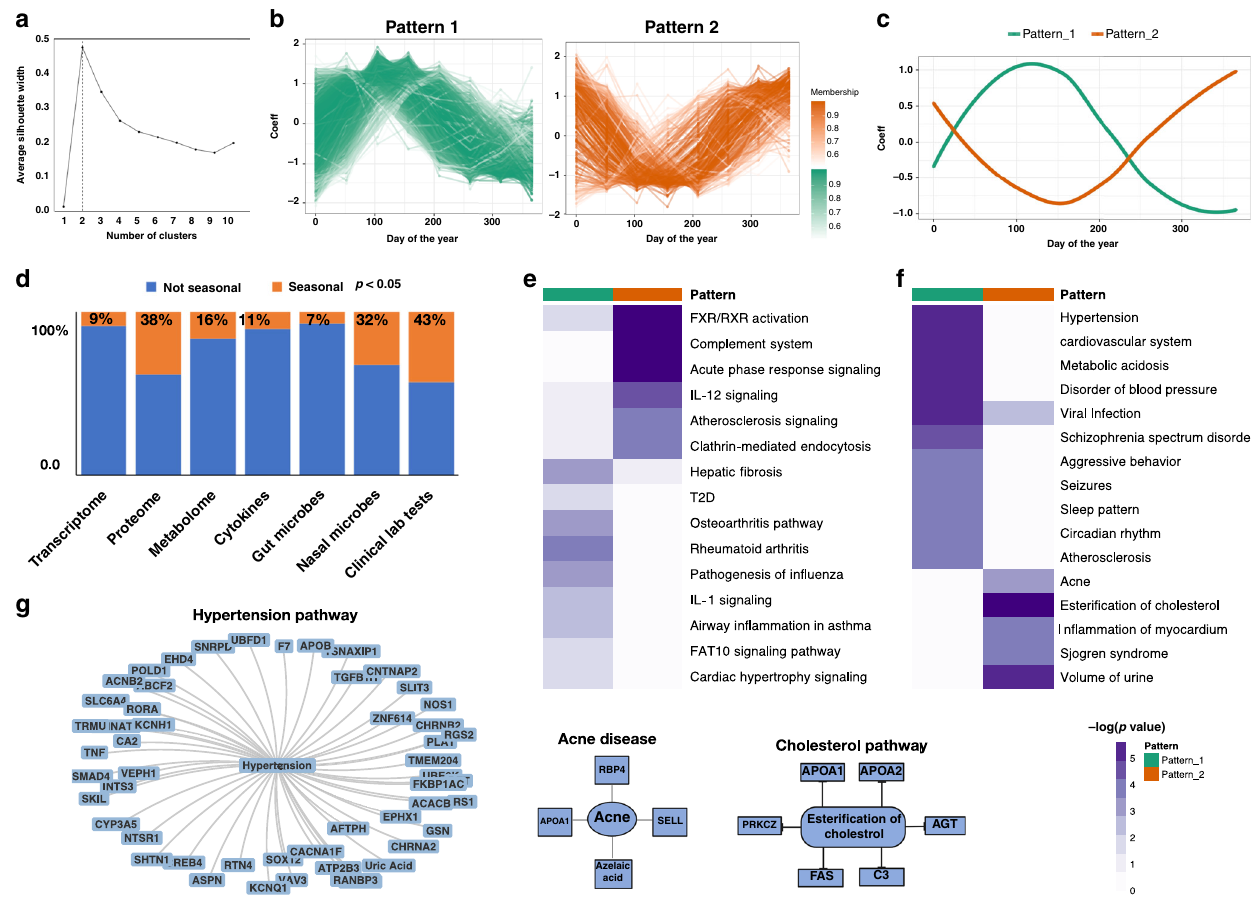
Fig. 2 Multiomics seasonal clusters and biological pathways. a Silhouette width plot for identifying the optimal number of clusters for all the host omics analytes combined as well as individual omes ‘ (Elbow plots in Supplementary Fig. 2). The X -axis shows the number of clusters (k) and the Y -axis shows average silhouette width. The silhouette plot shows the silhouette coef fi cient over values of k clusters ranging from 1 to 10. This plot shows the highest average silhouette coef fi cient occurring at k = 2. b Fuzzy C-means clustering of seasonal patterns for all omics analytes combined. The X -axis shows days of the year (1-365 days) and the Y -axis shows normalized GAMM coef fi cients (omics pattern one is shown in green color and omics patterns two is shown in orange color). c Summarized patterns for all the omics analytes combined as well as individual omes ‘ (Supplementary Fig. 3) (omics pattern one is shown in green color and omics pattern two is shown in orange color). d Summary of proportion of omics analysts with seasonality effects ( GAMM model likelihood ratio test p -value ≤ 0.05) per ome. e Integrative canonical pathway analysis and f Integrative disease analysis of omics analytes and their enrichment with seasonal patterns 1 and 2. The heatmap plot shows the − log 10 (adj- p values). g Examples of disease enrichment analysis of seasonal patterns. Hypertension, acne and esteri fi cation of cholesterol pathways are